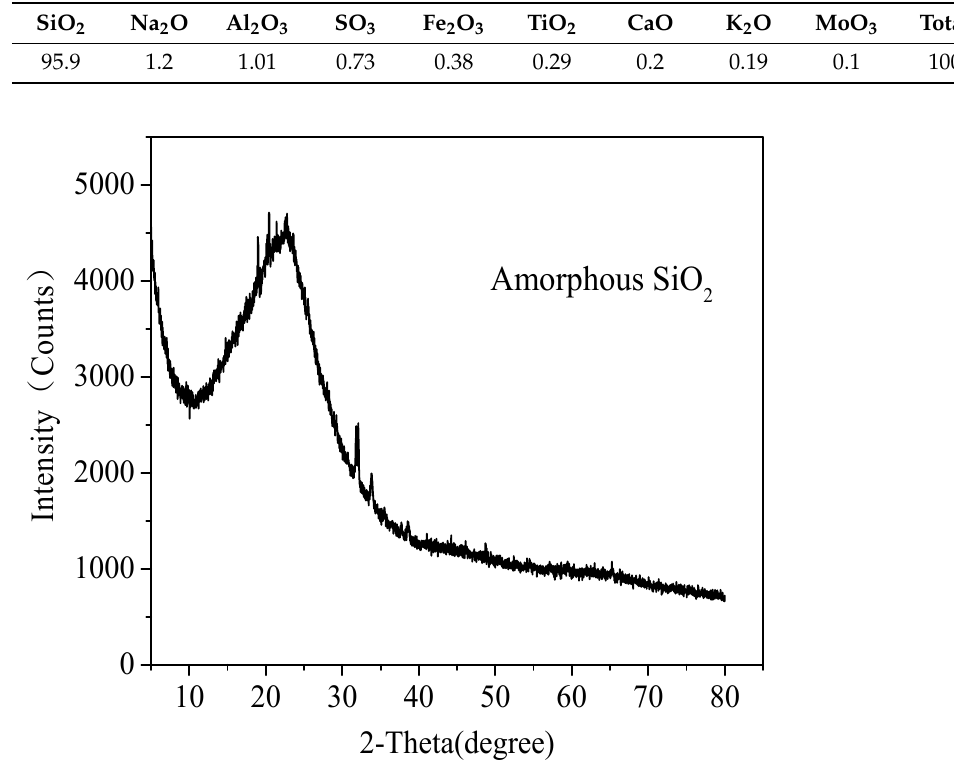
Table 3. The physical properties of several aerogel products. Sample Identification